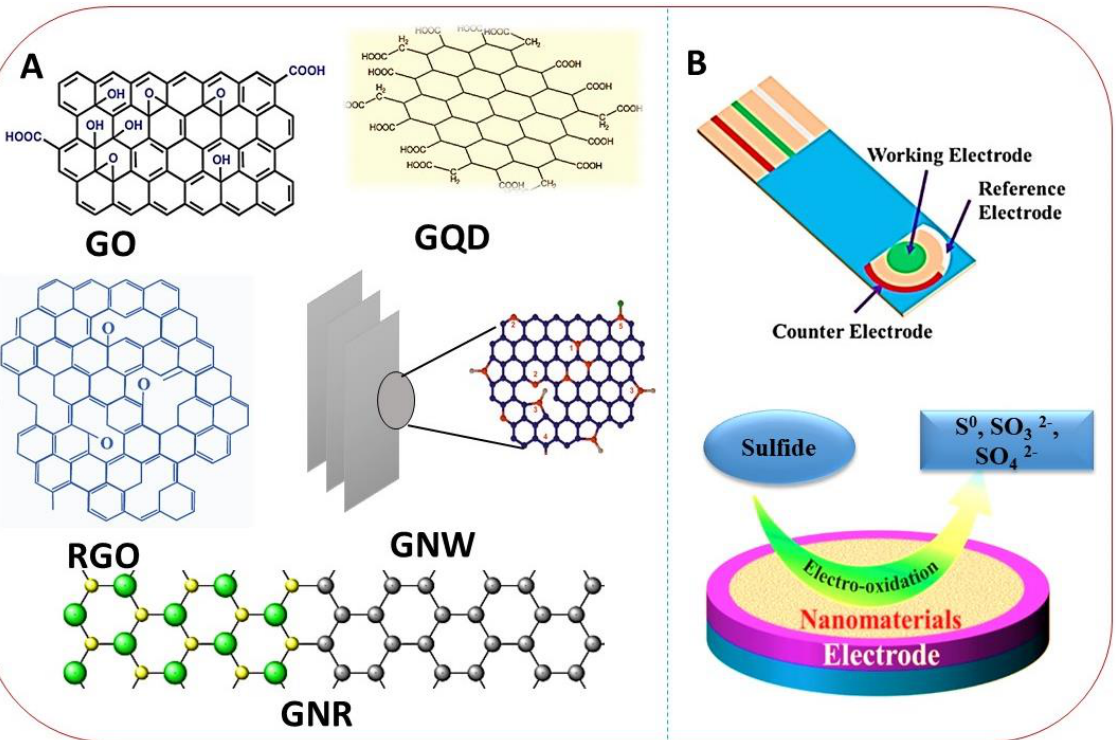
Figure 2. ( A ) Structural demonstration of various GR derivatives. ( B ) A simple depiction of an SPCE and mechanism of EC sulfide oxidation on the electrode surface. Reprinted with permission from Ref.